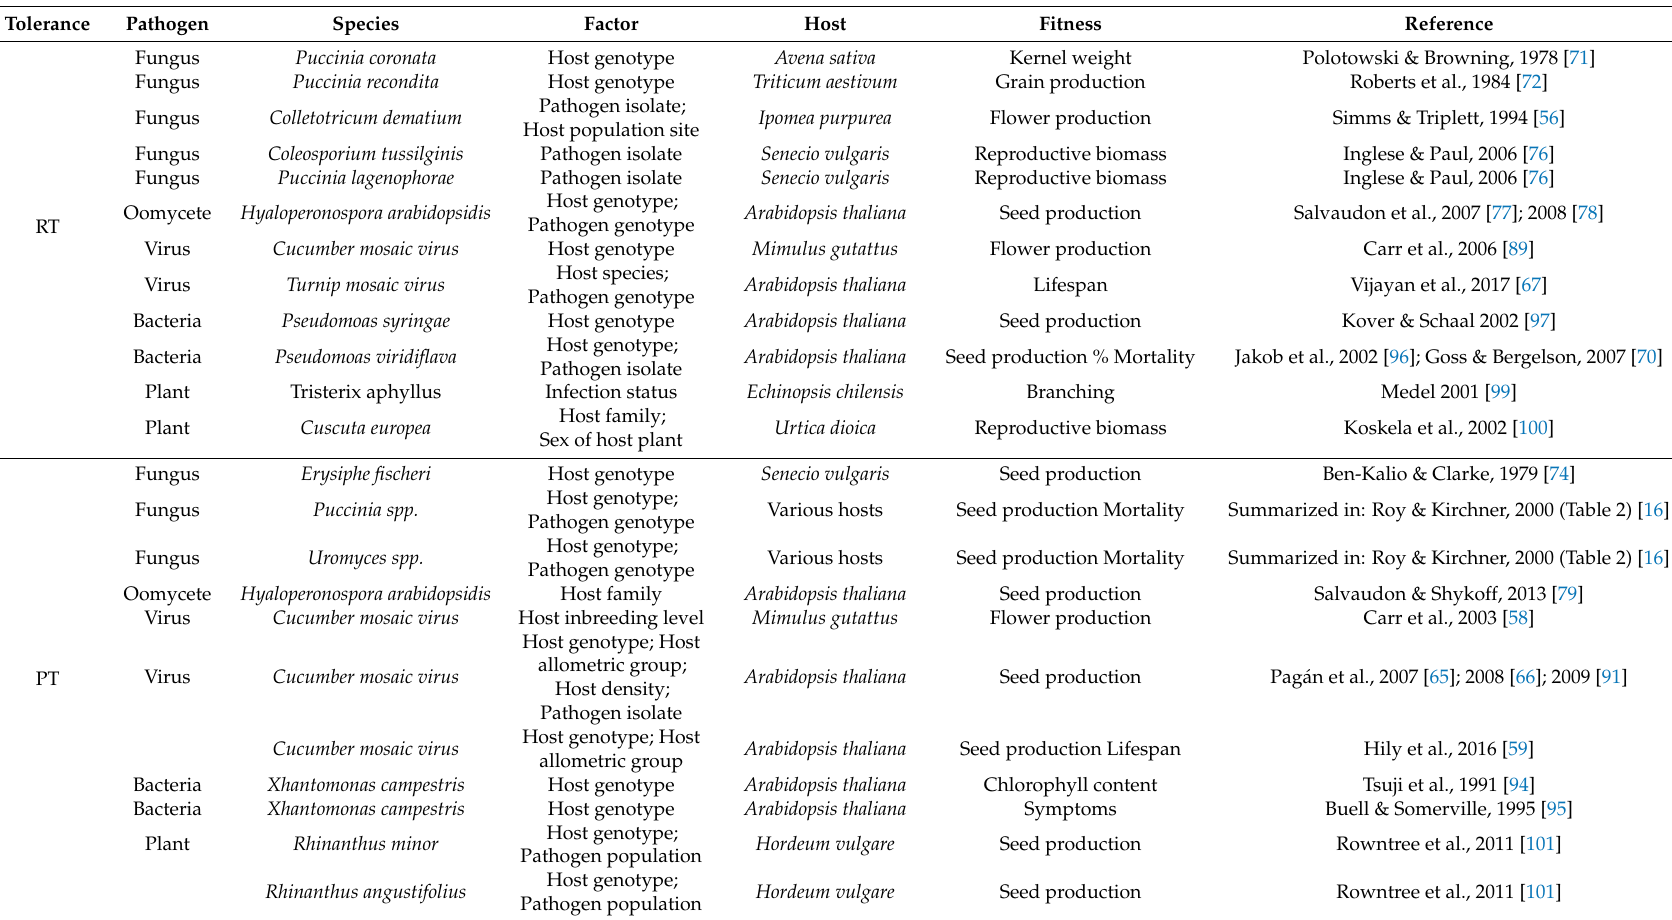
Table 1. Studies of plant tolerance, measured either as range tolerance (RT) or point tolerance (PT), to fungi, oomycetes, viruses, bacteria and parasitic plants.